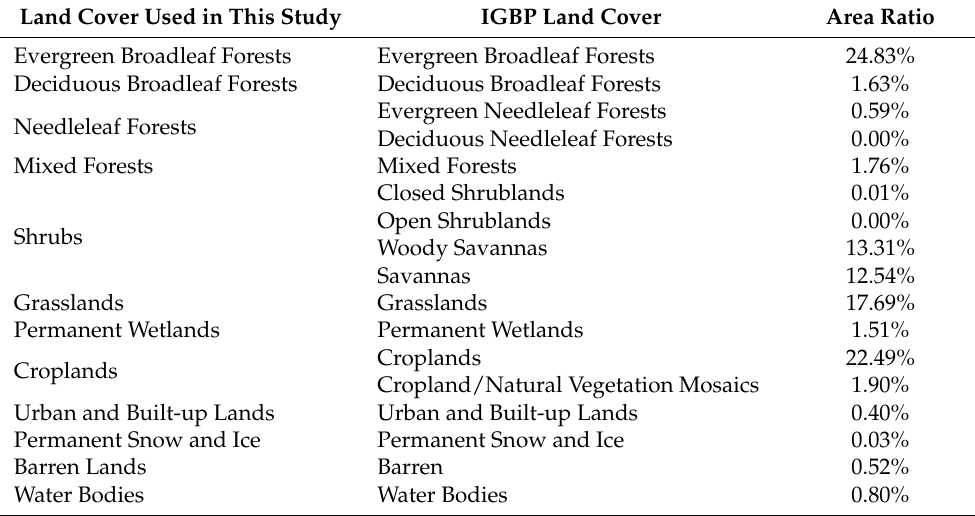
Table 1. Land cover types and percentage coverage in LMRB in 2019.